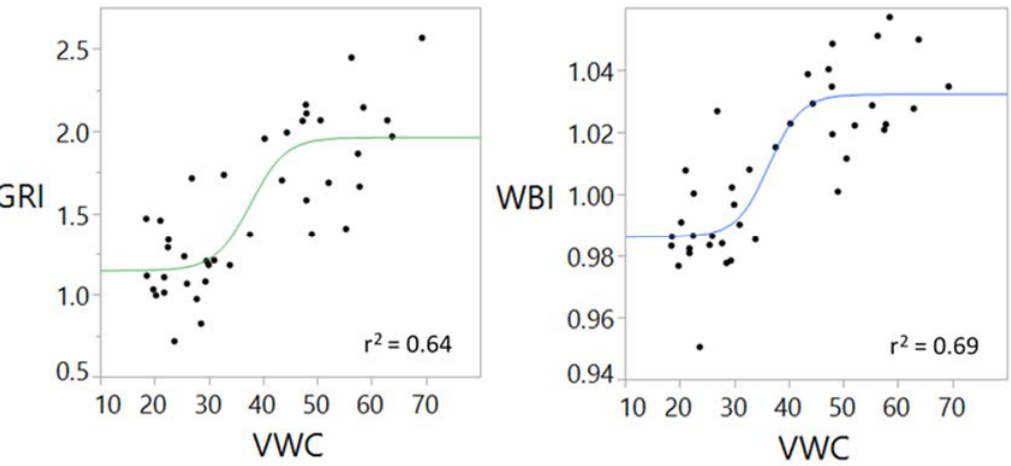
Figure 4. Nonlinear four parameter logistic regression for the green-to-red ratio index (GRI) and the water band index (WBI) compared to soil volumetric water content (VWC) for 26 July 2017.